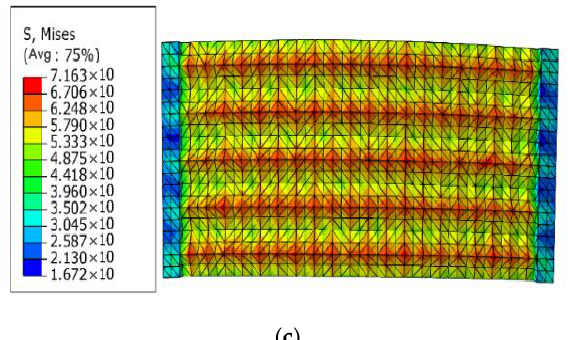
Figure 3. Static stress distribution nephogram of three different bionic shapes: ( a ) irregular, ( b ) hexagonal surface form, and ( c ) quadrilateral surfaces.